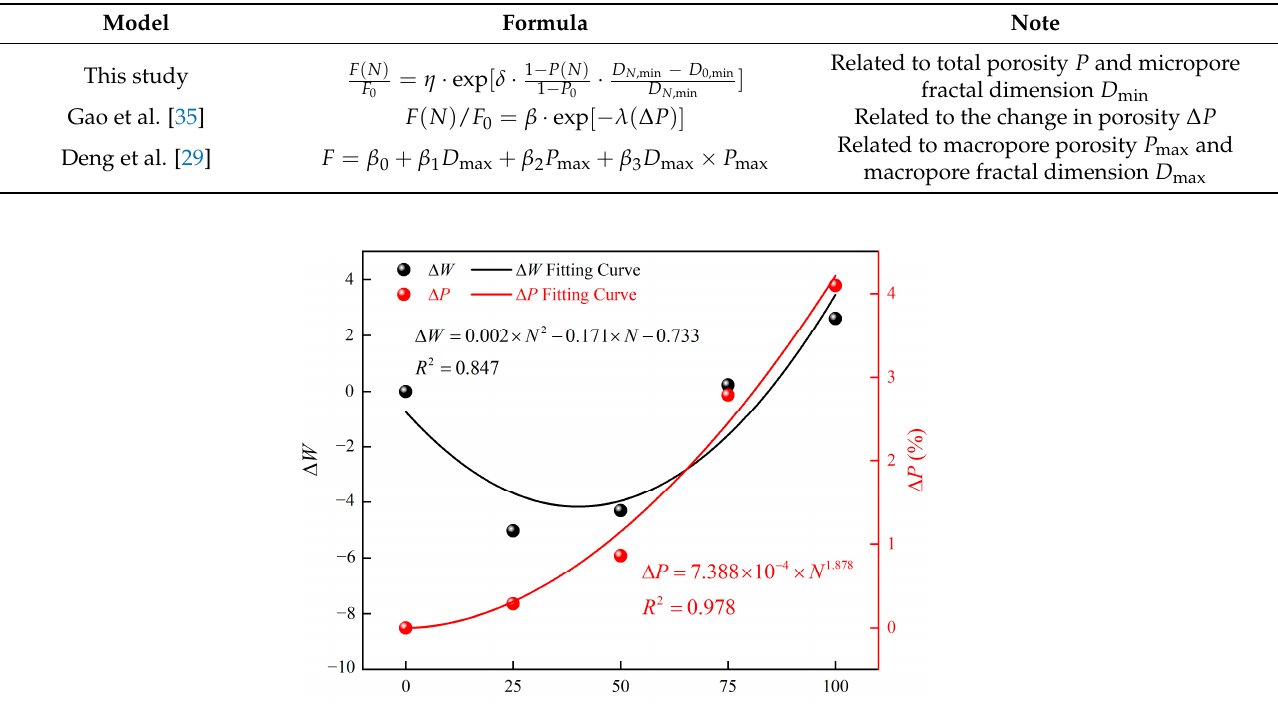
Table 5. Summary of prediction models.